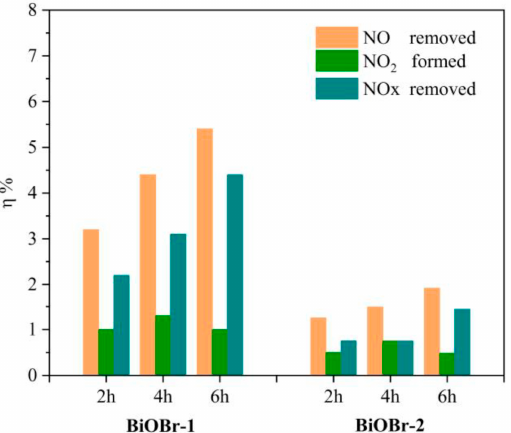
Figure 2. NO-NOx removed and NO 2 formed efficiency of modified samples with different autoclaved curing time. claved curing